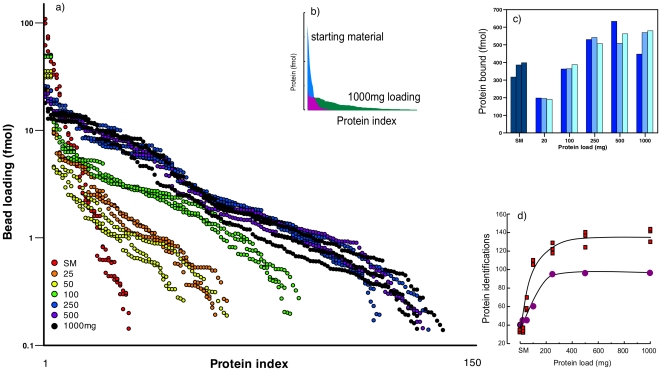
Gain in protein identification achieved by equalization.Prospectrum II beads were exposed to very high levels (up to 1000 mg protein/20 mg beads) of chick skeletal muscle soluble proteins in a final volume of 1.0 mL of 20 mM sodium phosphate buffer, pH 7.0. After 2 h, the beads were washed exhaustively (8 successive washes in the same buffer) and the suspension of beads was incubated with trypsin for digestion of bound proteins. The resultant peptides were analyzed by LC-MS/MS by data-dependent gel-LC-MS/MS and data independent LC-MS/MS. Panel a) shows the individually sorted abundance profiles as the beads were loaded from 25 to 1000 mg of starting protein (SM = starting material) and data are expressed as fmol on column. Each independent LCMS run was sorted independently from high to low abundance. The equalization was evident from the altered profile of the top 100 proteins on a linear abundance scale (panel b). The total protein bound is presented in panel c (n = 3) and number of proteins identified by label-free quantification (squares, n = 3) or gel-LCMS/MS (circles, n = 1) is given in panel d.